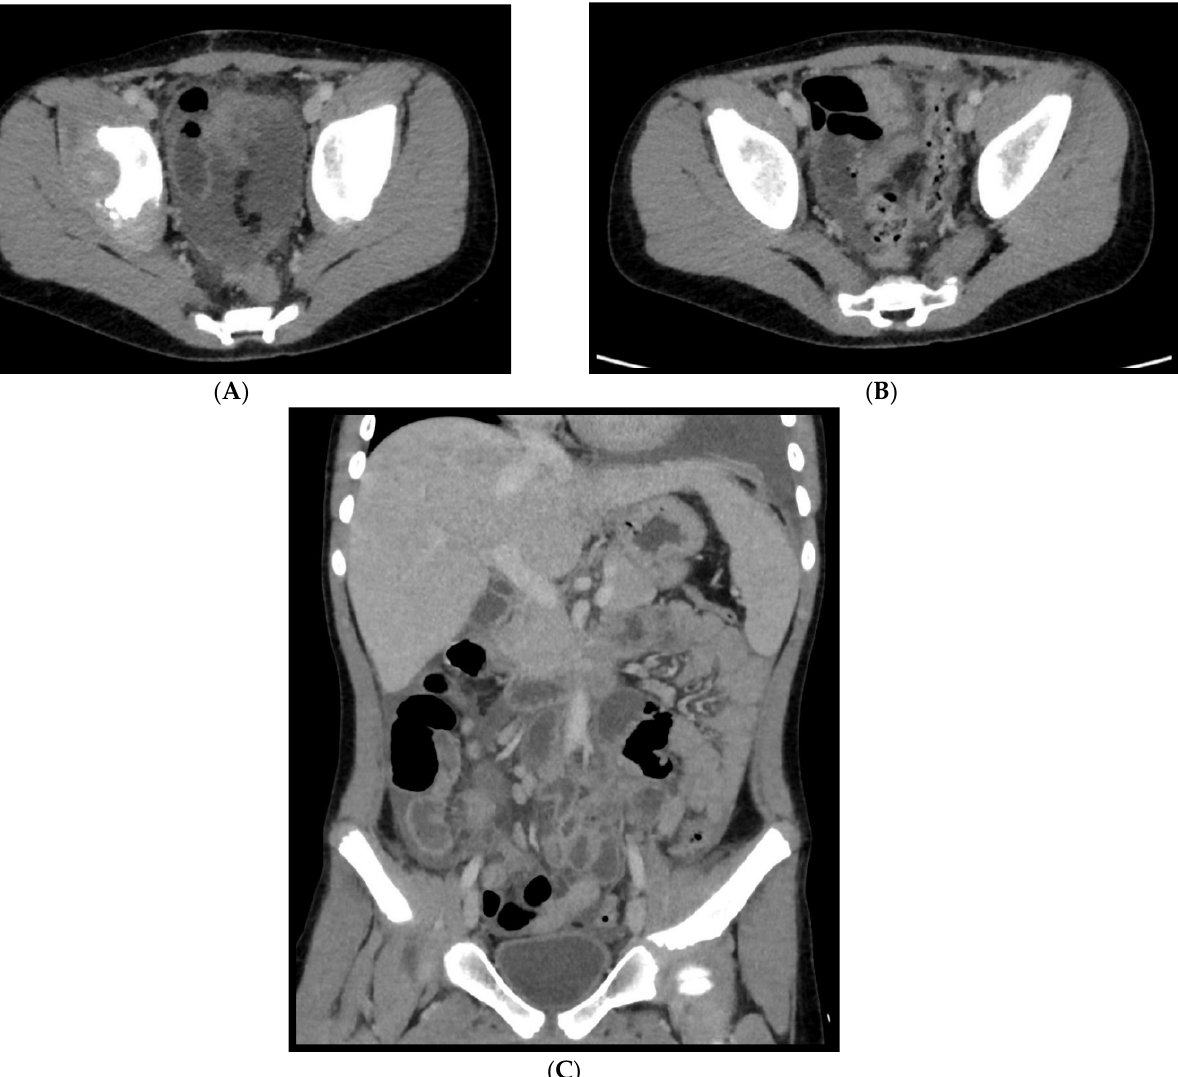
Figure 16. An 11-year-old patient with MIS-C. ( A – C ): Abdominal effusion with cecum and sigma hyper enhancing wall thickening.